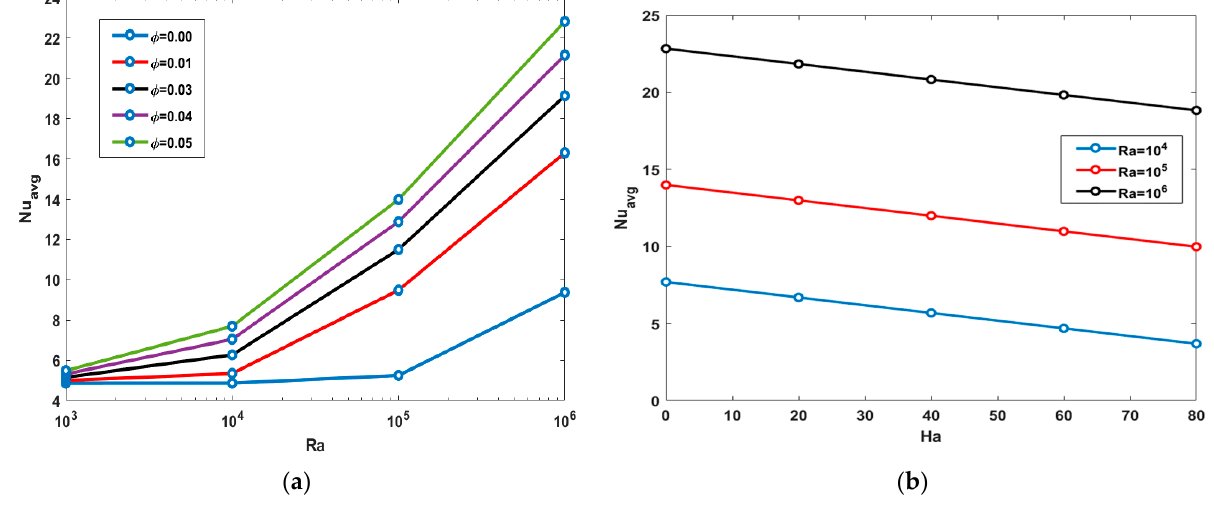
Figure 8. ( a ). E ff ect of Rayleigh number on the average Nusselt number for Ha = 25 and various Figure 8. ( a ). Effect of Rayleigh number on the average Nusselt number for Ha = 25 and various nanoparticles volume fractions. (b) E ff ect of Hartman number on the average Nusselt number for ϕ nanoparticles volume fractions. ( b ) Effect of Hartman number on the average Nusselt number for = 0.04 and various Rayleigh numbers. φ = 0.04 and various Rayleigh numbers.